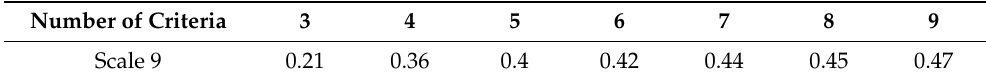
Table 8. Consistency rate